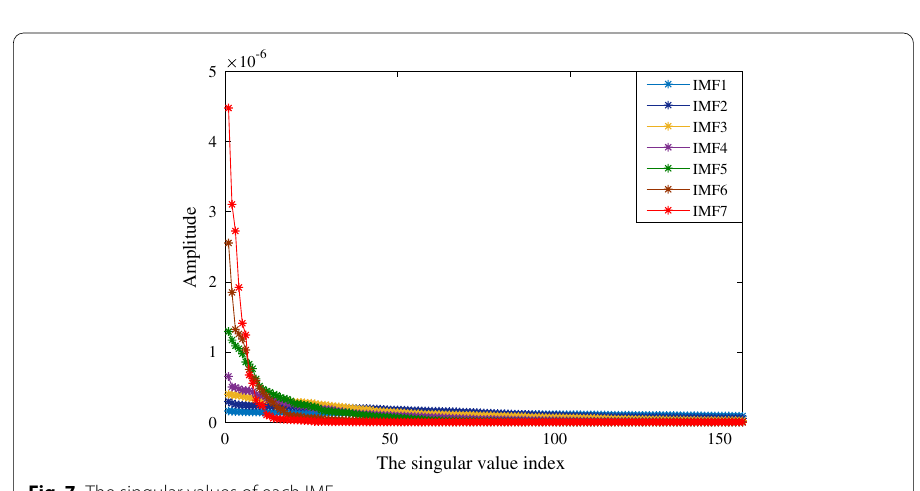
Fig. 7 The singular values of each